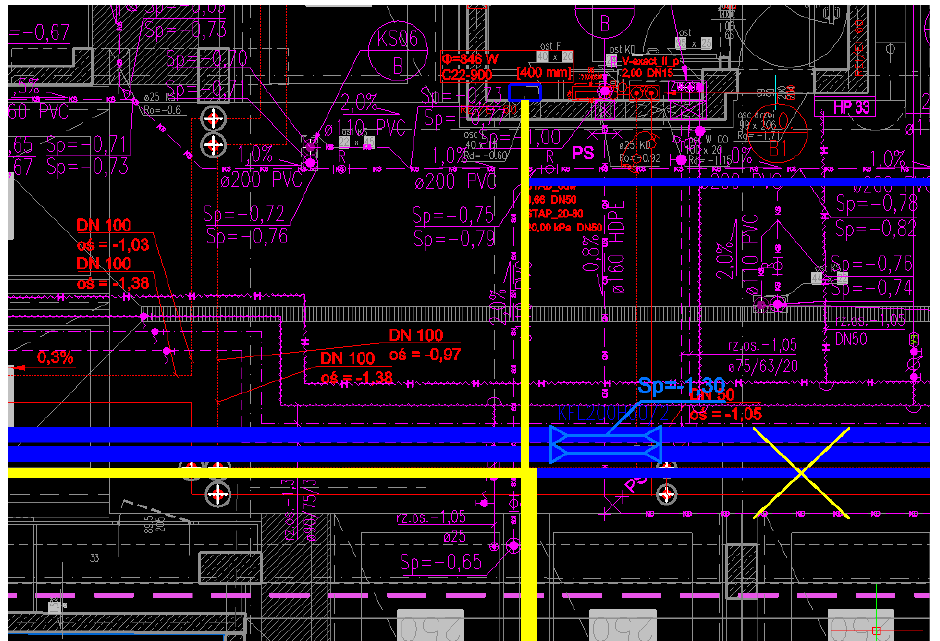
Figure 3. Clash detection during a 2D traditional design process.